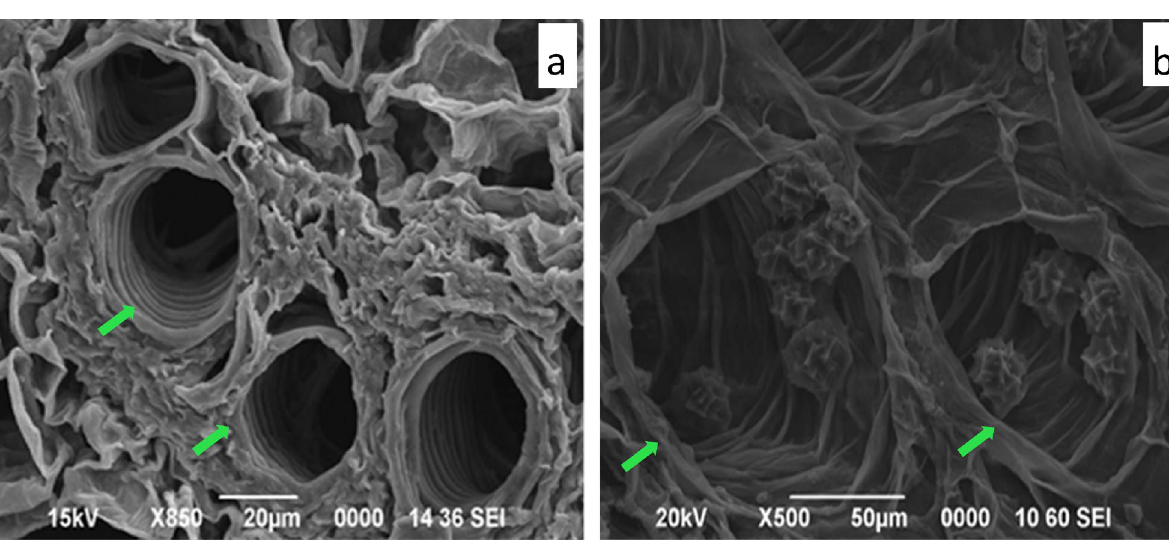
Figure 4. SEM micrographs of transverse section of T. natans stem: ( a ) control stem showing well-preserved vascular bundles, ( b ) Sb treated stem showing changes in vascular